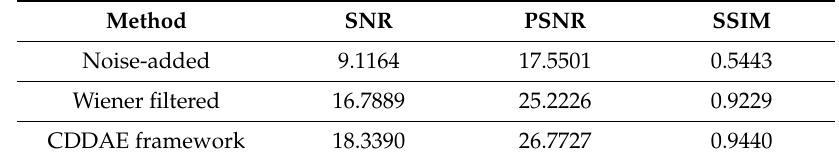
Figure 4. ( a ) Image simulation result of monolayer graphene using MacTempas; ( b ) Noise-added simulation image; ( c ) Denoising result of the noise-added image with the Wiener filter; ( d ) Denoising result of the noise-added image with the CDDAE framework. Table 2. Average values of SNR, PSNR, SSIM for the Wiener-filtered dataset and CDDAE framework.